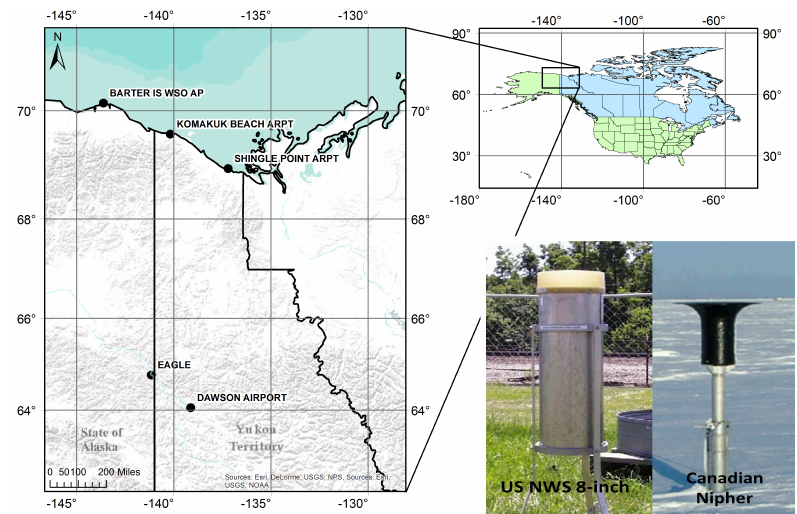
Figure 1. Study areas and locations of selected climate stations, and photos of the national standard gauges, NWS 8in. gauge (left) and the Nipher snow gauge (right), respectively, for the USA and